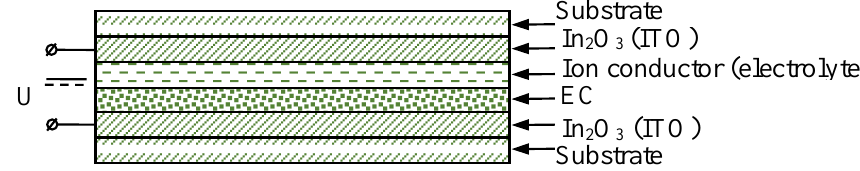
U Figure 18. ECD Figure 18. ECD structure.